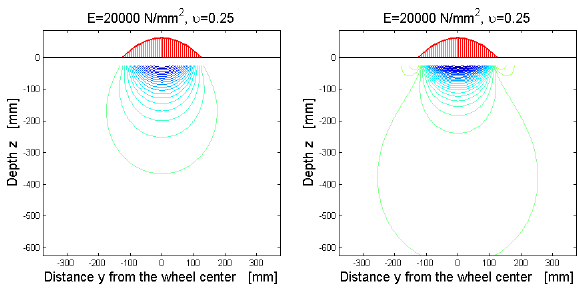
Figure 25: σ z contours on the A-A vertical cross-section of Figure 24: Boussinesq’s solution on the left and the second order solution on the right.